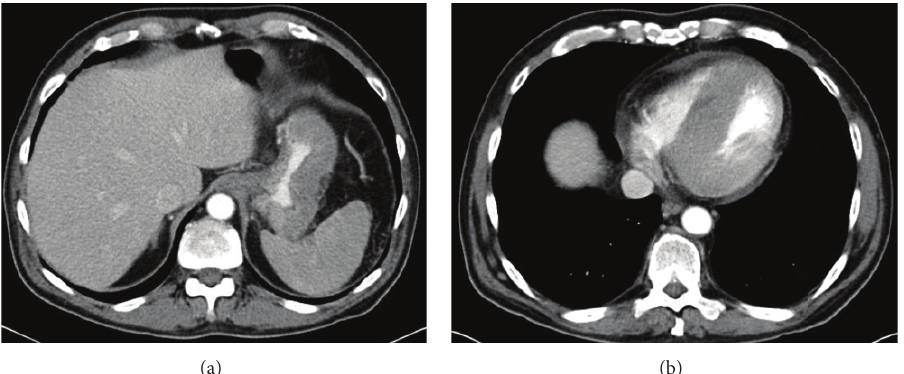
Figure 1: Computed tomography showing diffuse thickening of the gastric wall (a) and interventricular septum (b) due to infiltration of myeloid sarcoma.